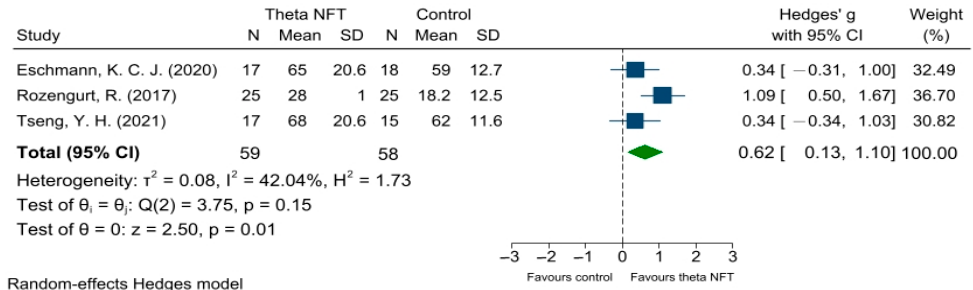
Figure 4. Forest plots showing meta-analysis of NFT of theta activity on EM in healthy participants. CI = confidence interval; SD = standard deviation [13,17,32].